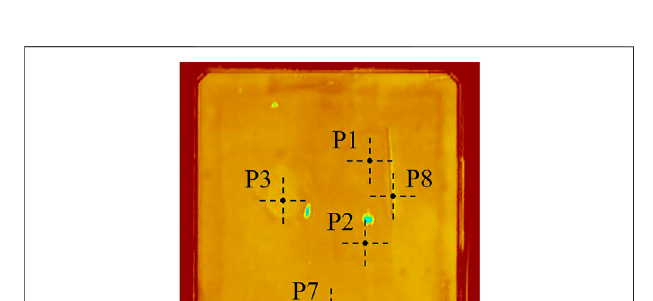
FIGURE 8 | Transmission C-scan Tomography images in different TOF intervals.